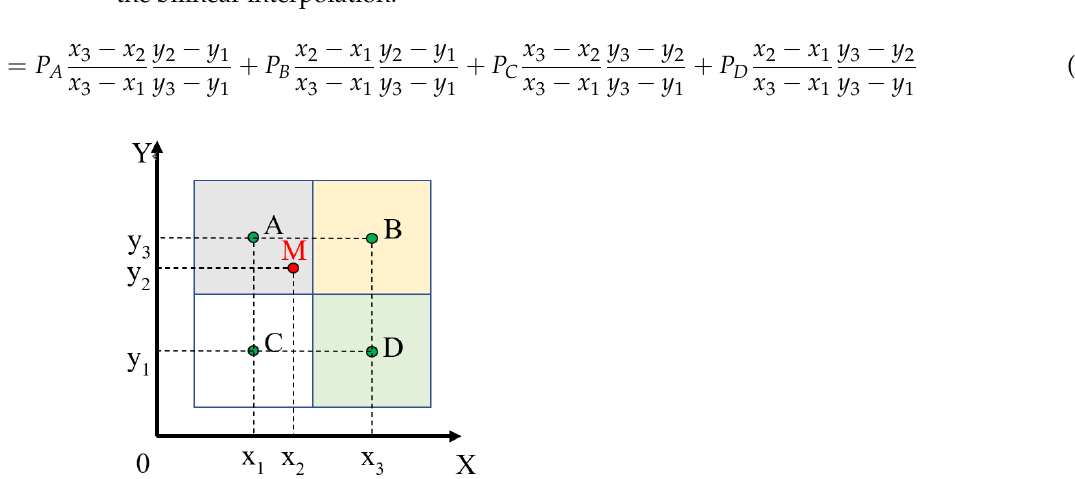
Figure 2. Schematic diagram of bilinear interpolation. Different background colors represent different grids.